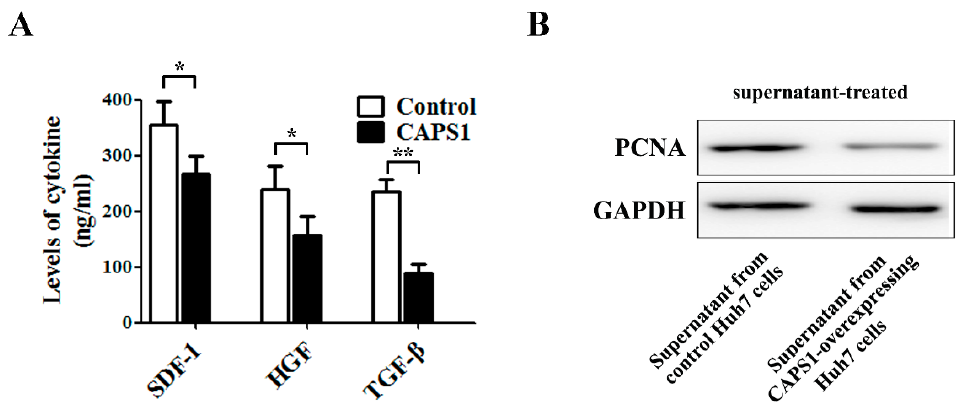
Figure 4. CAPS1 overexpression changed microenvironment in HCC cells. ( A ) The levels of stromal cell-derived factor 1 (SDF-1), hepatocyte growth factor (HGF), and transforming growth factor-beta (TGF- β ) were determined by enzyme-linked immunosorbent assay (ELISA) in culture supernatant derived from Huh7 cells stably transfected with control vector or CAPS1; ( B ) Huh7 cells were treated with the culture supernatant from Huh7 cells stably transfected with control vector or CAPS1. Forty-eight hours later, the expression of proliferating cell nuclear antigen (PCNA), a marker of cellular proliferation, was detected by Western blotting. GAPDH: glyceraldehyde 3-phosphate dehydrogenase. * p < 0.05; ** p < 0.01.